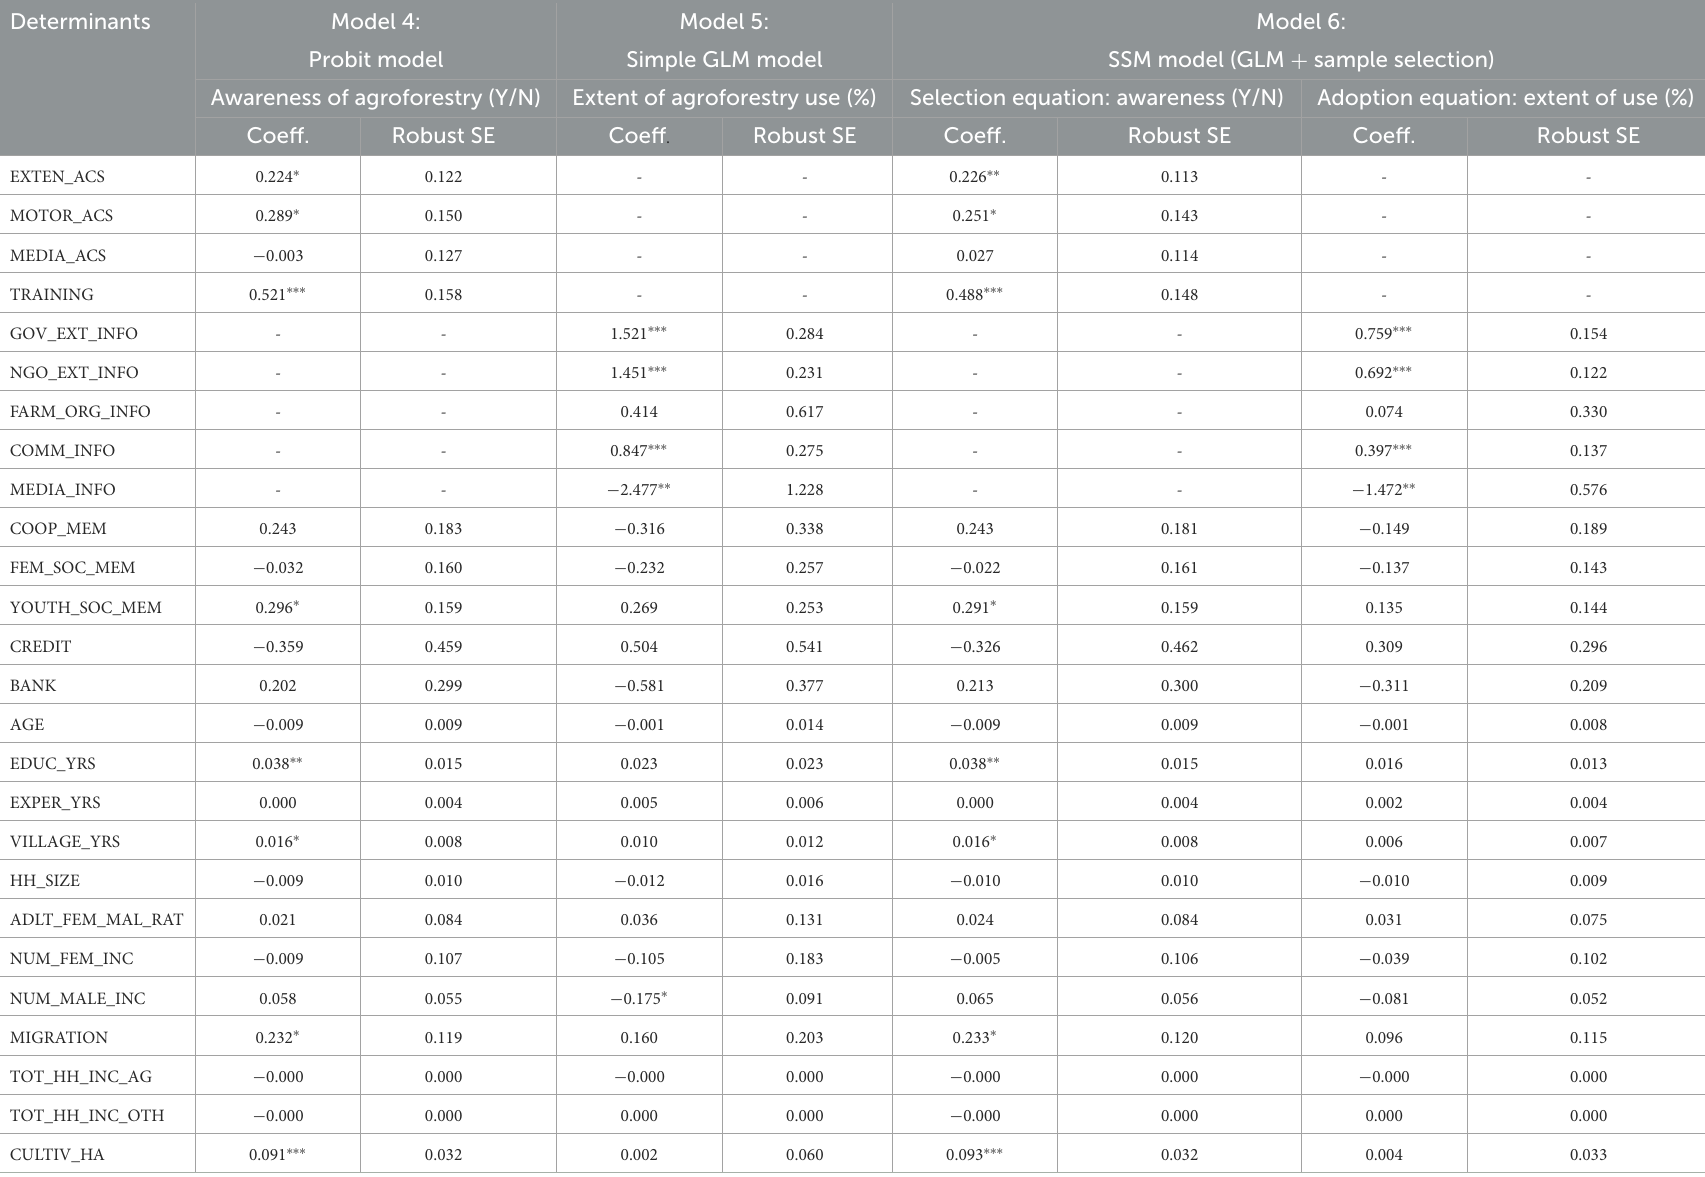
TABLE 6 Model estimates for agroforestry awareness and adoption in Fatick, Senegal, with and without sample selection.